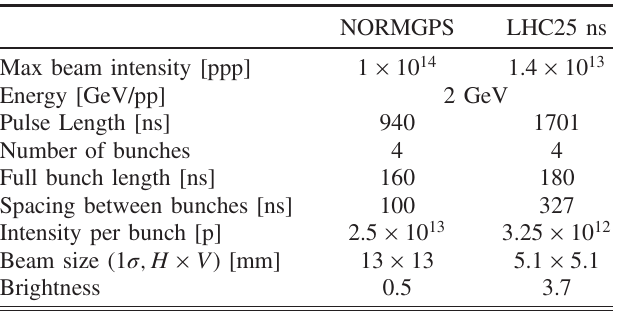
TABLE I. Parameters of the most critical beams for the operation of the dump, after LS2: NORMGPS and LHC25 ns